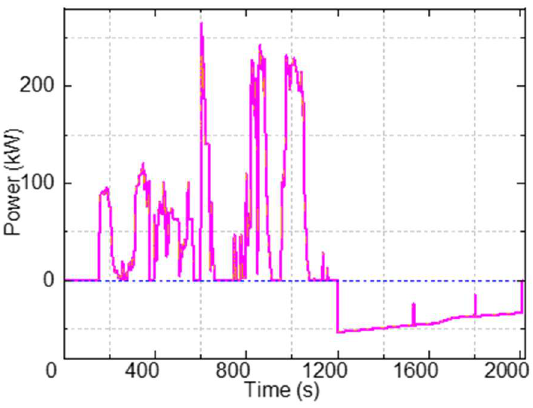
Figure 14. Input and output power of the hydraulic pump/motor.